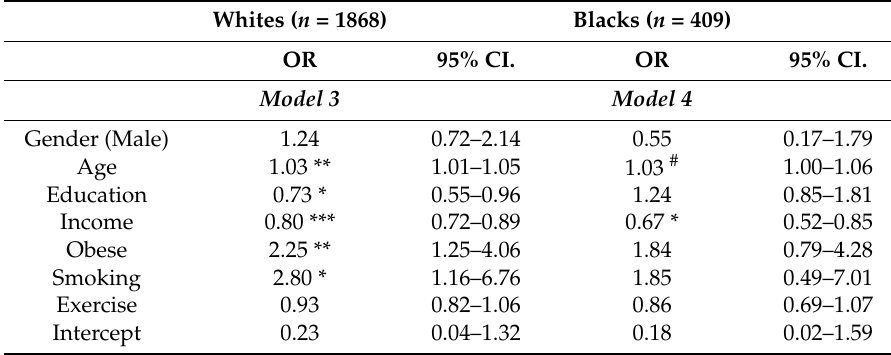
Table 3. Summary of logistic regression models across